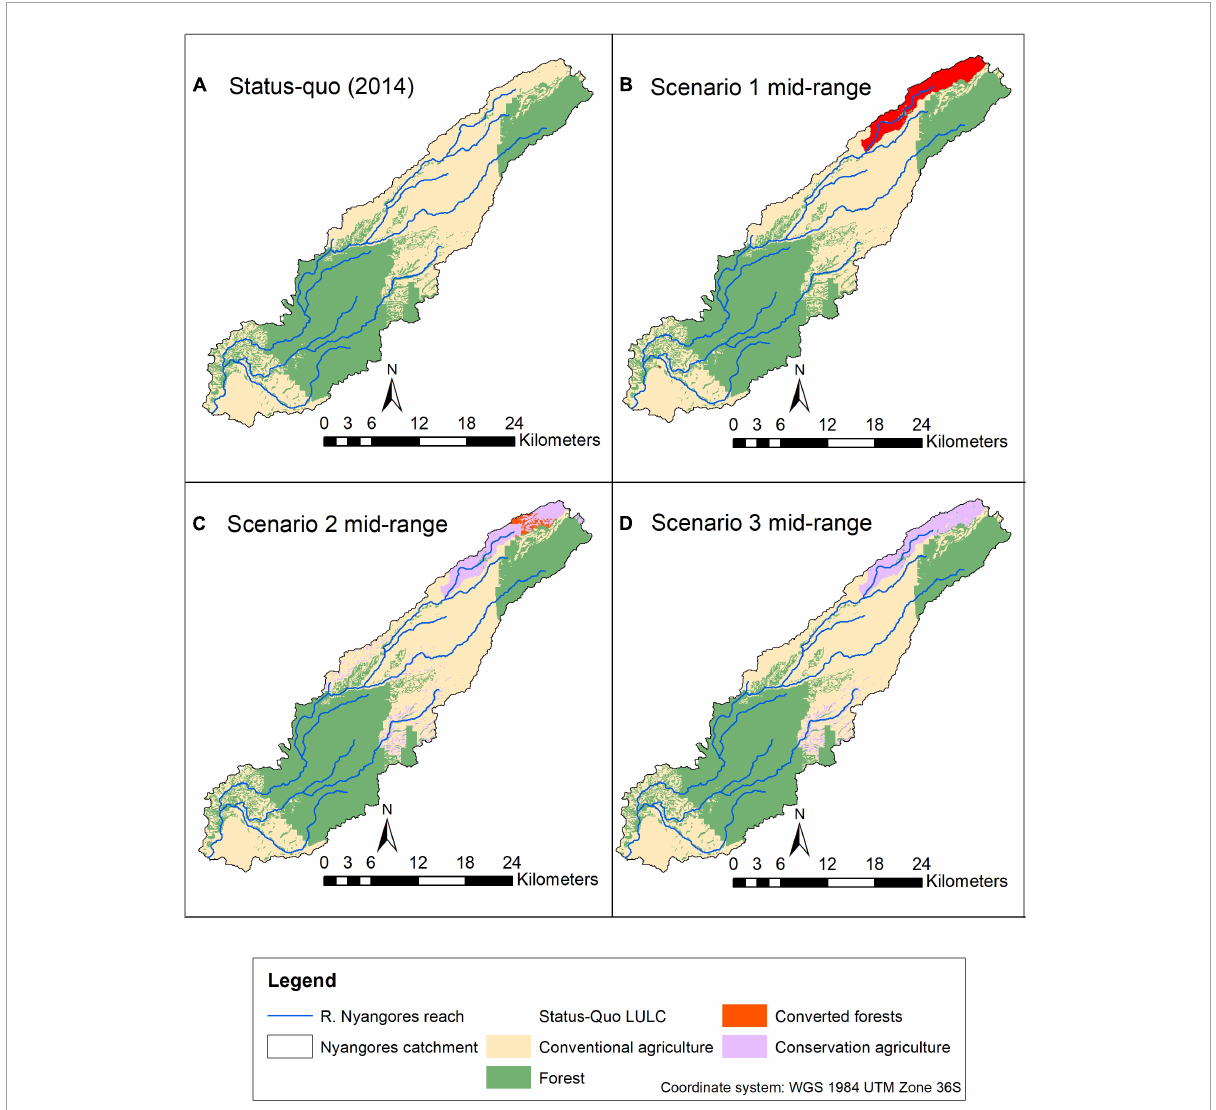
FIGURE6 Spatial distribution of the different land-uses for the mid-range solution for Scenario 1 (B) , Scenario 2 (C) , and Scenario 3 (D) , relative to the base Scenario (A)